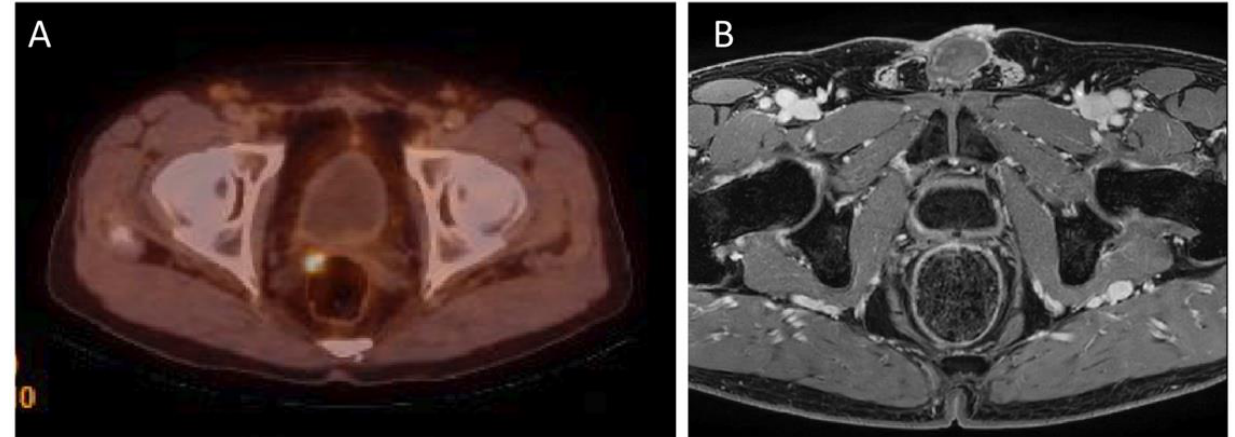
Figure 1. ( A ) — 18 F-PSMA-1007 PET/CT examination of a patient (74 years old) after radical prosta- tectomy eight years before, Gleason Score 7(3 + 4), current PSA level 0.29 ng/mL. 18 F-PSMA-1007 focal uptake in right side tissues adjacent to the prostate bed, in the level under seminal vesicle, pararectaly with SUVmax = 6.9 was detected, confirming local recurrence. ( B ) this lesion cannot be seen on the corresponding MRI examination (Images from Riga Stradins University Radiology re- search laboratory archive).